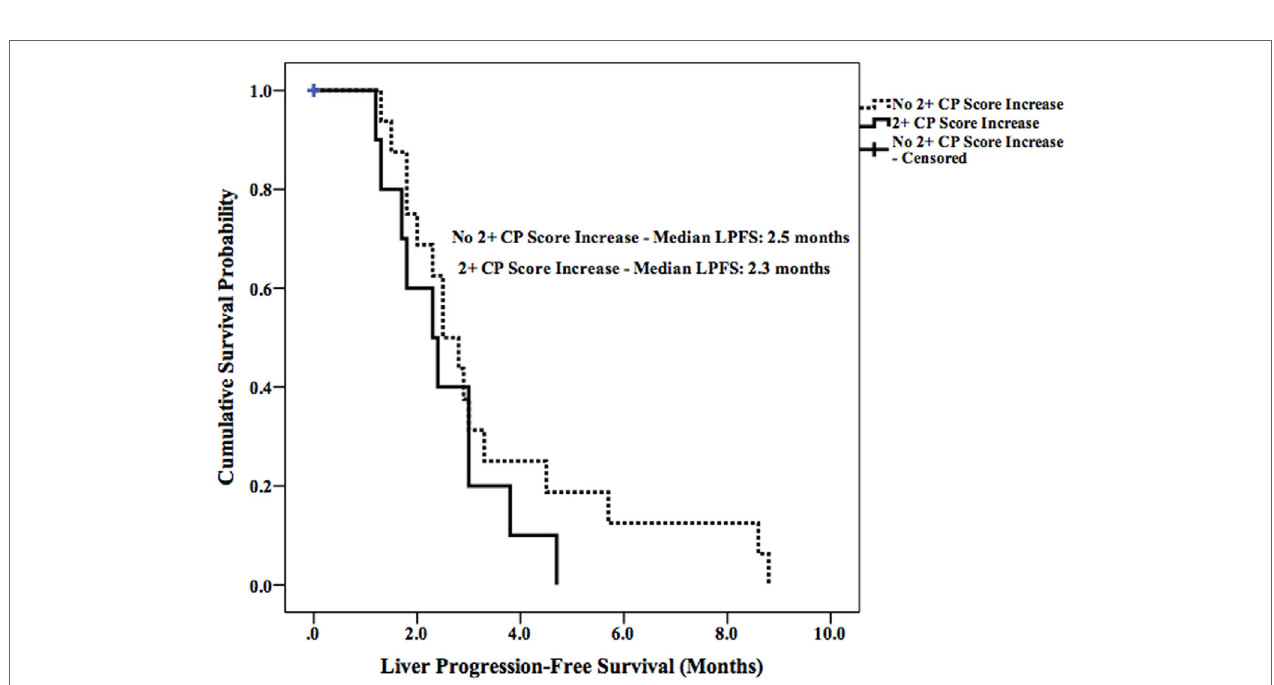
FigUre 5 | Kaplan–Meier curves comparing lPFs in patients with or without a 2 + increase